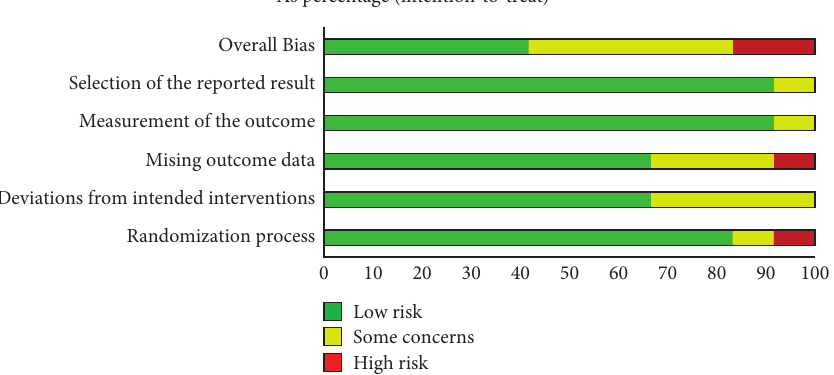
Figure 2: Risk of bias by outcome